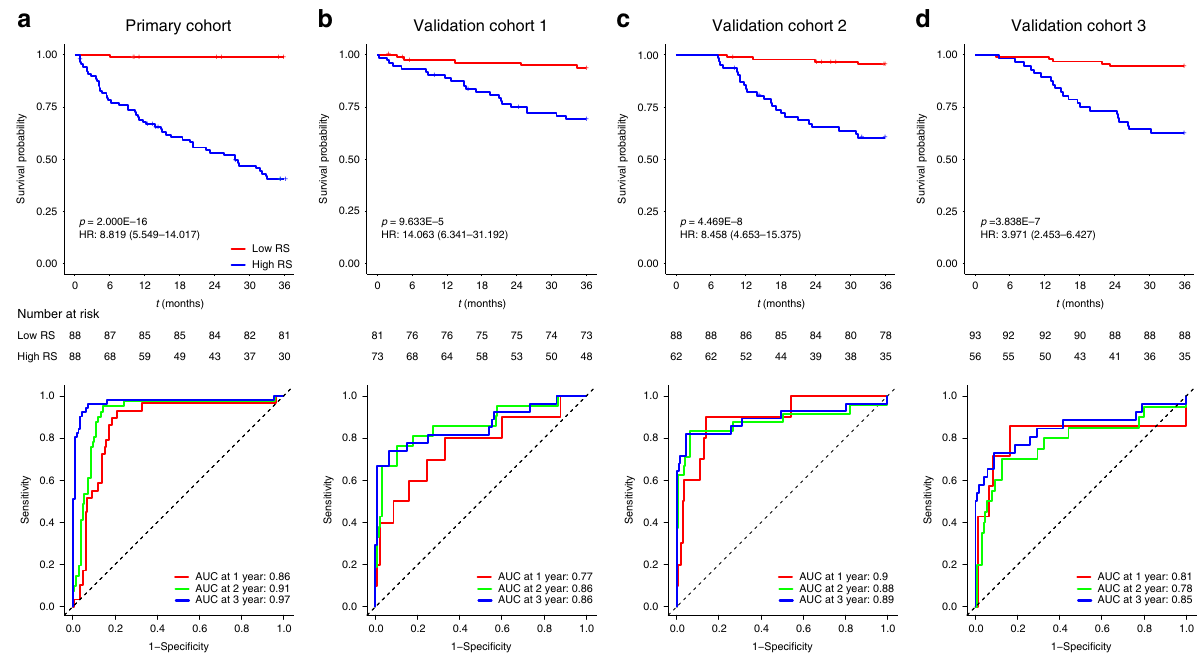
Fig. 1 K – M and time-dependent ROC curves according to the RS. p values were calculated using two-sided log-rank test, and AUCs at 1 year, 2 years, and 3 years were calculated to assess the prognostic accuracy within the primary cohort ( a : n = 176), validation cohort 1 ( b : n = 154), validation cohort 2 ( c : n = 150), and validation cohort 3 ( d : n = 149). AUC area under the curve; HR hazard ratio; ROC receiver operating characteristic; RS radiomic signature. Source data are provided as a Source Data fi le.